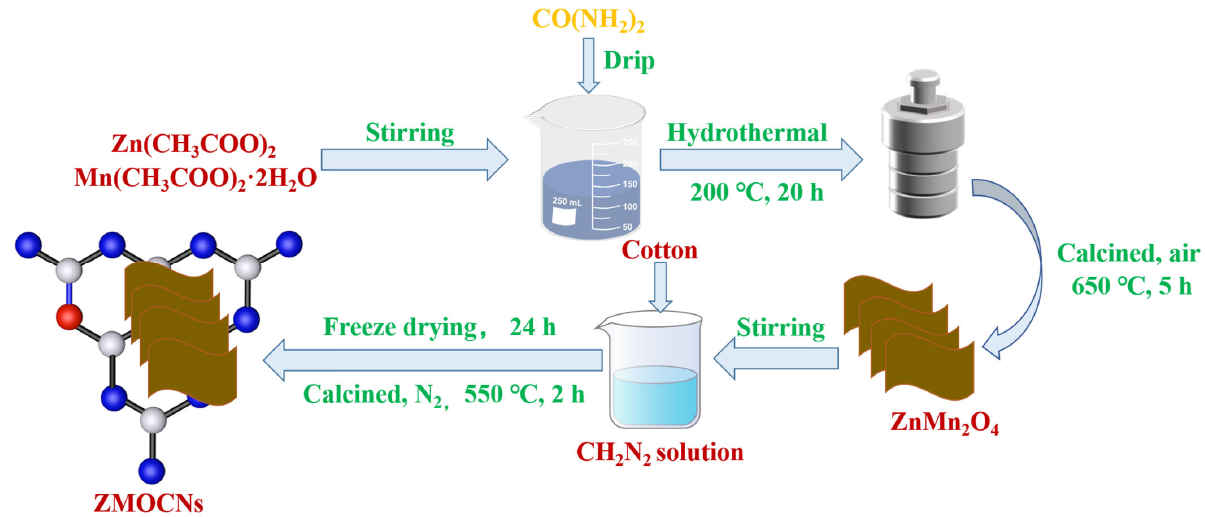
Figure 10. Schematic illustration of the synthesis of nitrogen ‐ deficient ZMOCNs.